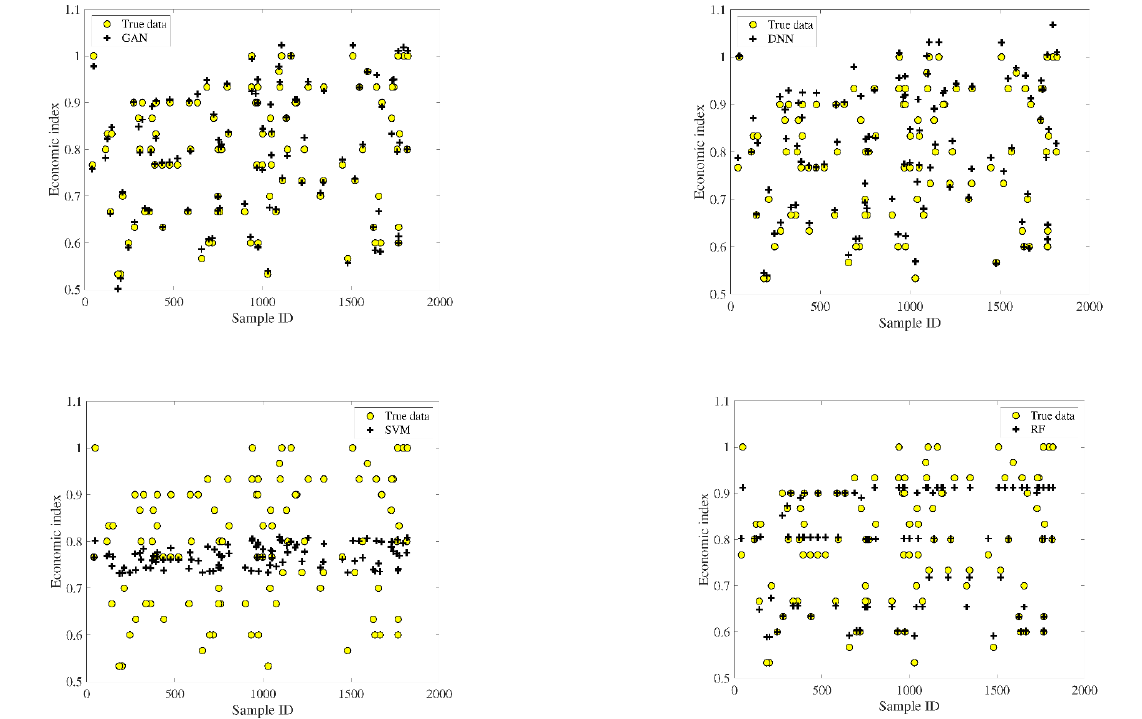
Figure 10. Comparison of the economic index prediction of the PMLM models built by proposed GAN and baseline methods. GAN and baseline